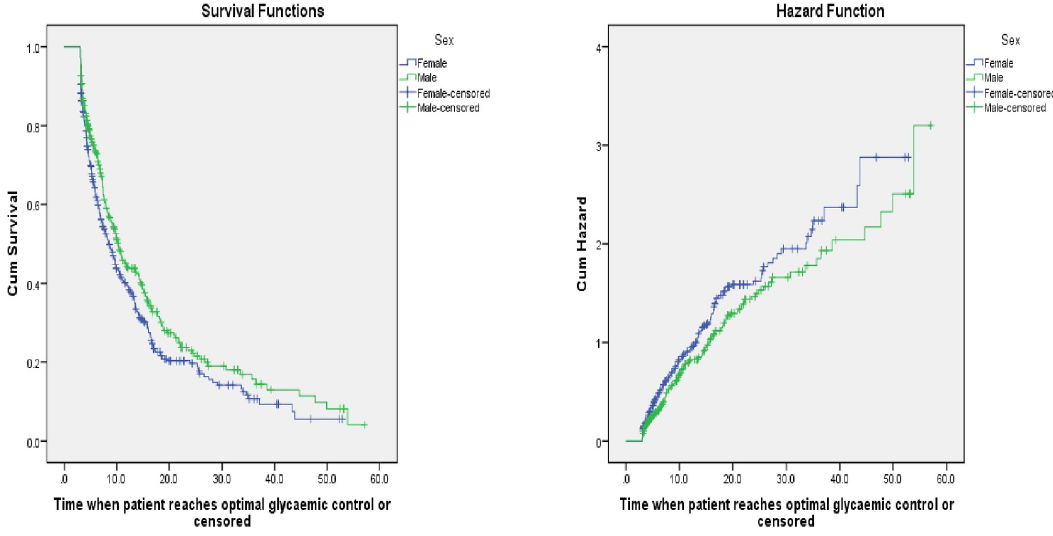
Fig 1. Survival and hazard functions of sex by time, Addis Ababa, 2018.